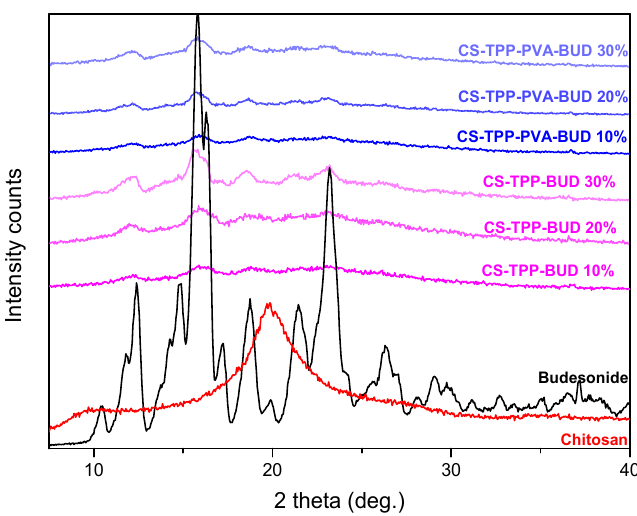
Figure 5. XRD patterns of CS, BUD and CS nanoparticles containing BUD in different concentrations of 10%, 20%, 30% w/w.